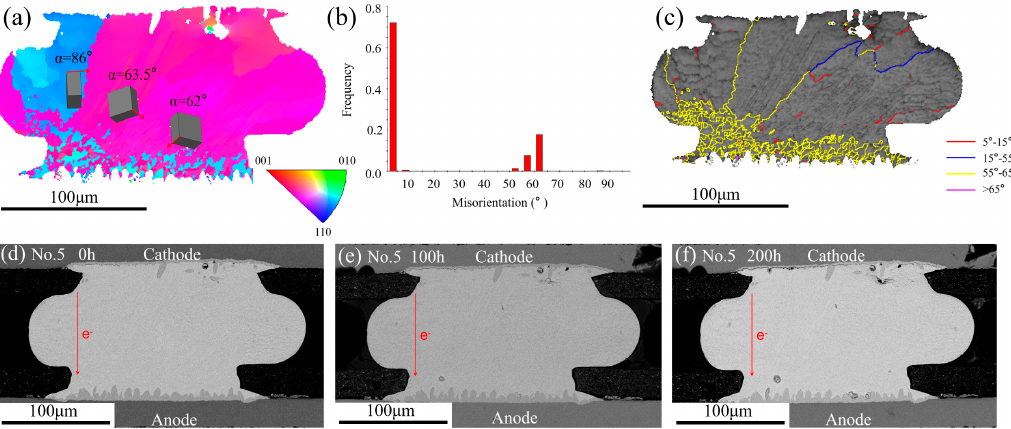
Figure 9. ( a ) EBSD map of the No.5 solder joint after reflow; ( b ) the misorientation distribution map; ( c ) the grain boundary distribution map; SEM images of the No.5 solder joint after different current stressing times: ( d ) 0 h; ( e ) 100 h; ( f ) 200 h.